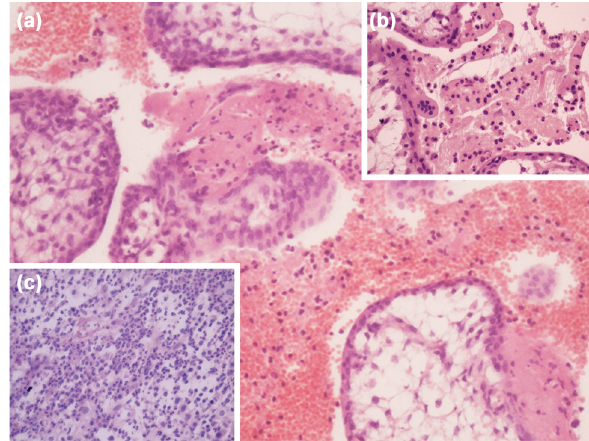
Figure 2: Histological features of chorioamnionitis caused by Serratia marcescens . Photomicrographs of the placental tissue show neutrophilic in fi ltrate of membranes and those overlying the chorionic plate with rare macrophages and without necrotic debris; ( a ) hematoxylin and eosin staining, × 200; ( b ) hematoxylin and eosin staining, × 400; ( c ) hematoxylin and eosin staining, ×